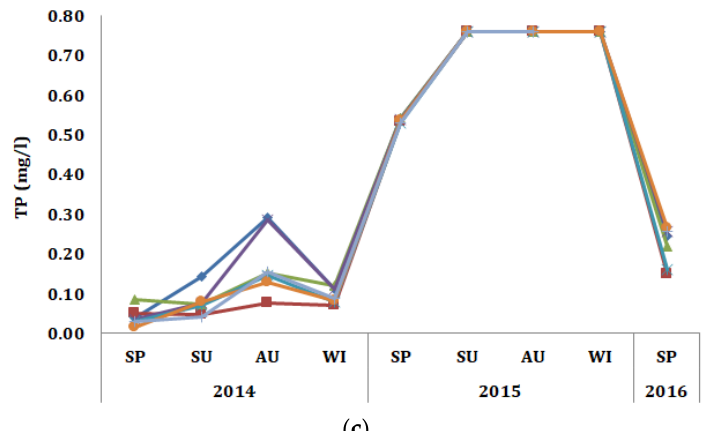
Figure 2. Seasonal variation of ( a ) Nitrite; ( b ) Ammonium and ( c ) Total phosphorus concentration in